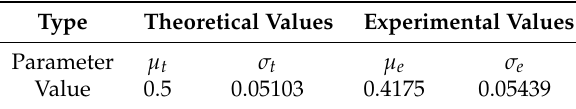
Table 3. Expected values ( t ) and experimental values ( e ) obtained from the entire 124,750 BER values.